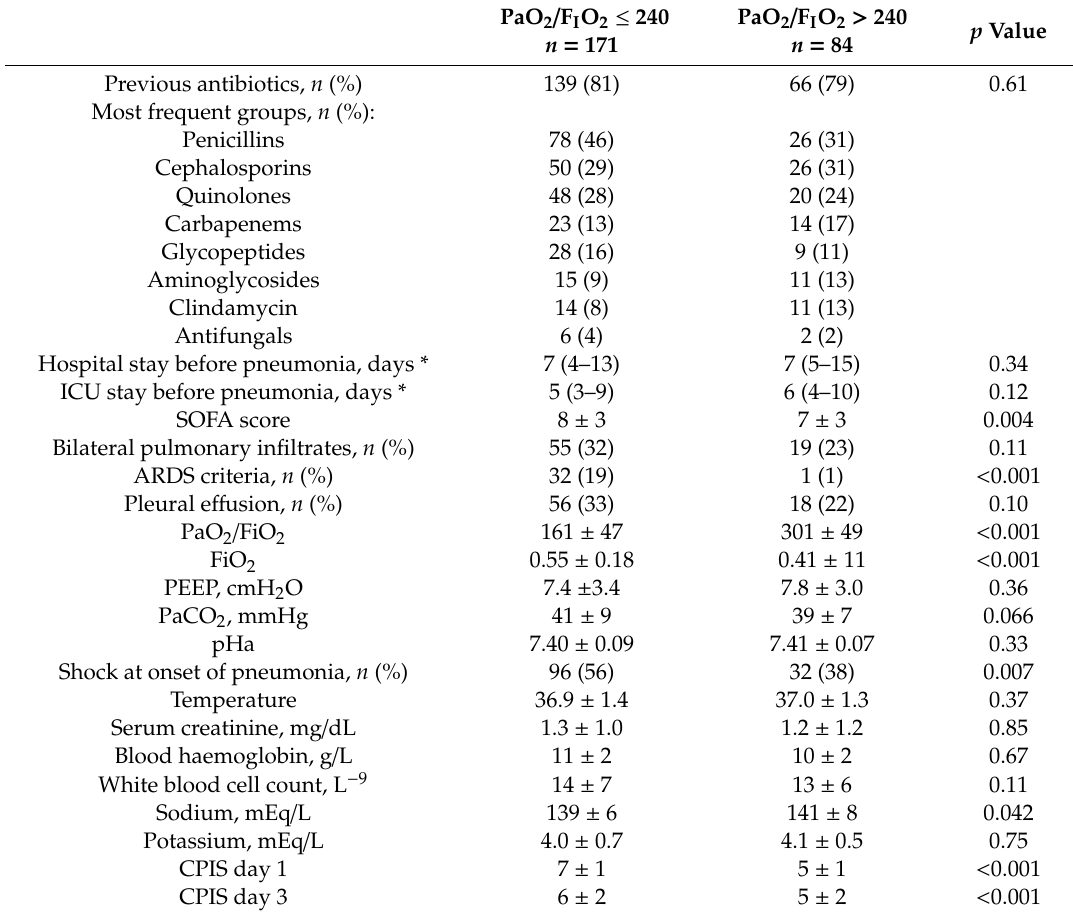
Table 2. Characteristics of patients at pneumonia